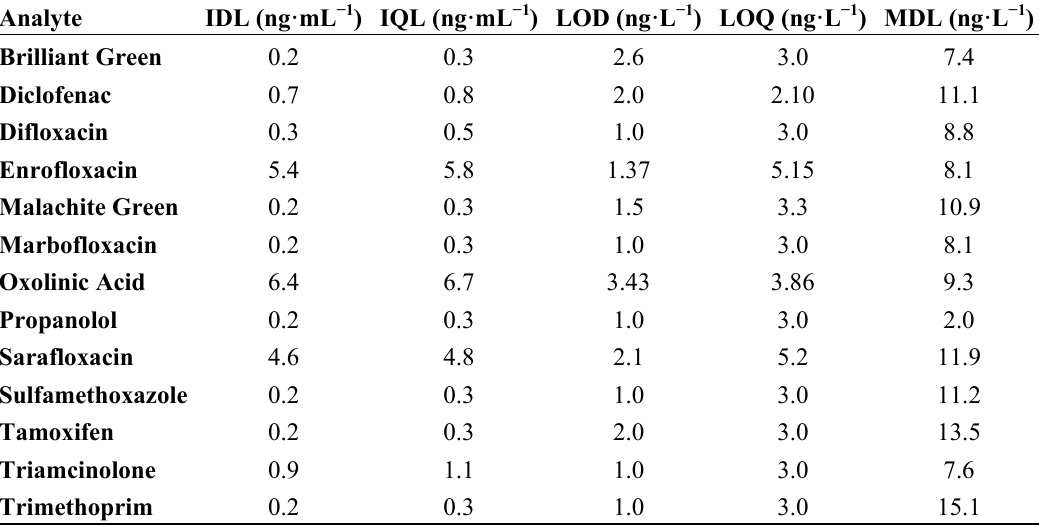
Table 4. Instrument detection limit (IDL), instrument quantification limit (IQL), limit of detection (LOD), limit of quantification (LOQ) and method detection limit (MDL). Analyte